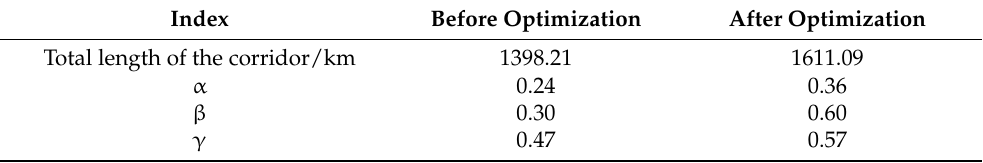
Table 5. Calculation results of ecological network structure indicators before and after optimization. Index Before Optimization After Optimization Total length of the corridor/km 1398.21 1611.09 α 0.24 0.36 β 0.30 0.60 γ 0.47